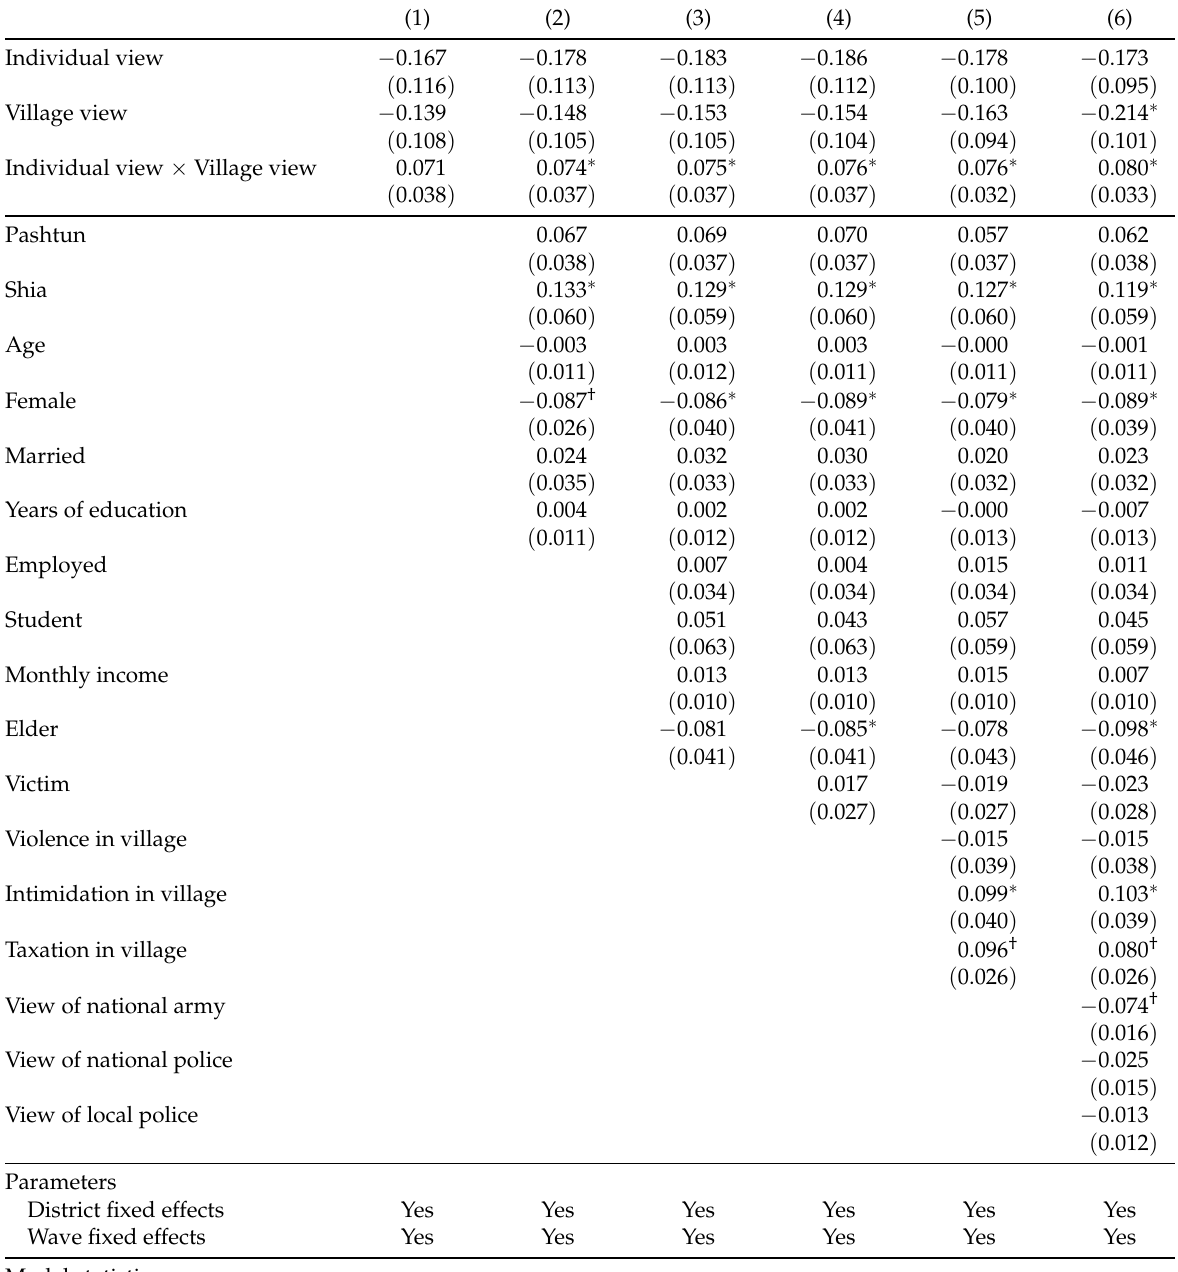
Table 3: Individual and village views of the Taliban and to whether individual reports wrongdoing to external authorities (compared to internal